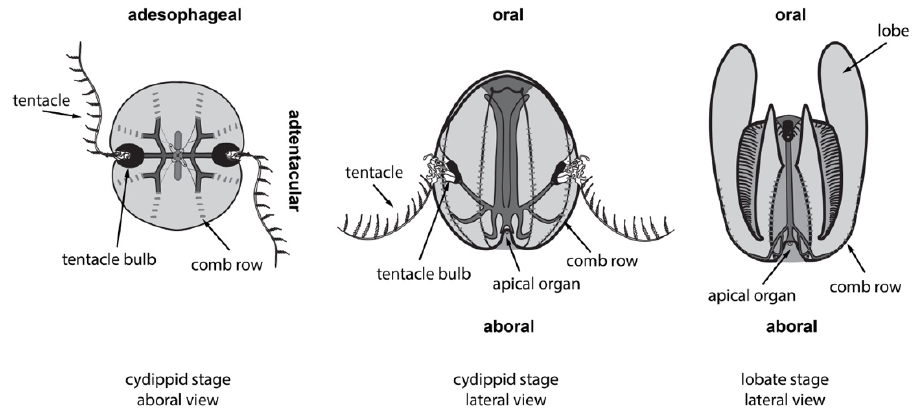
Figure 2. Body plans of the ctenophore Mnemiopsis leidyi . The major body axes (oral, aboral, adesophageal, and adtentacular) are labeled in bold for each view/stage. Their early postembryonic life is spent in the cydippid stage (left side). They spend most of their adult life in the lobate stage (right side). The overall morphology and body plan of both stages are similar, and the transition occurs gradually as they grow.